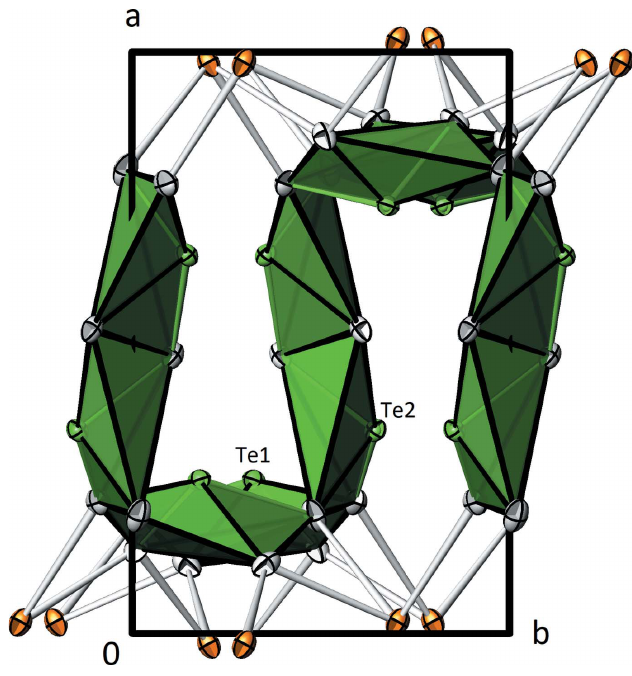
Figure 3 The crystal structure of (cid:2) -CdTe 2 O 5 in a projection along [001]. Displacement ellipsoids are drawn at the 90% probability